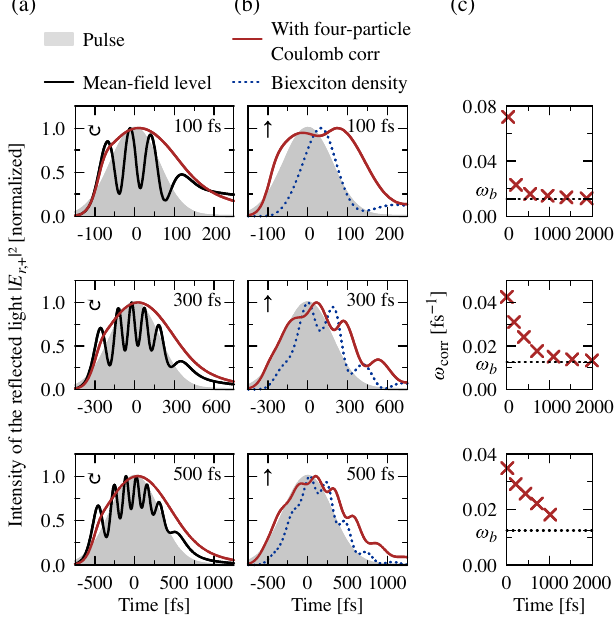
FIG. 3. (a),(b) Normalized intensity of the reflected light ð t Þj 2 as a function of time for a monolayer of MoS 2 at j E r; þ 5 K. The shaded areas illustrate the exciting (a) circularly ( ↻ ) or (b) linearly ( ↑ ) polarized pulses with varying intensity FWHM as indicated and fixed pulse areas Θ ¼ 2 π , and the laser pump energy ℏ ω ϵ is resonant to the exciton resonance energy ϵ . The p ¼ x; (cid:3) x; (cid:3) mean-field results and the dynamics including four-particle Cou- lomb correlations (i.e., biexcitons and two-exciton scattering continua) are shown as black and red solid lines, respectively. The biexciton density j B j 2 is shown as a blue dotted line. þ − ;b t Þ of the (c) Temporal evolution of the oscillation frequency ω corr ð t Þj 2 for linearly polarized intensity of the reflected light j E r; þ ð excitation including four-particle Coulomb correlations. The ϵ = ℏ frequencies approach the biexciton-binding frequency ω b ¼ b